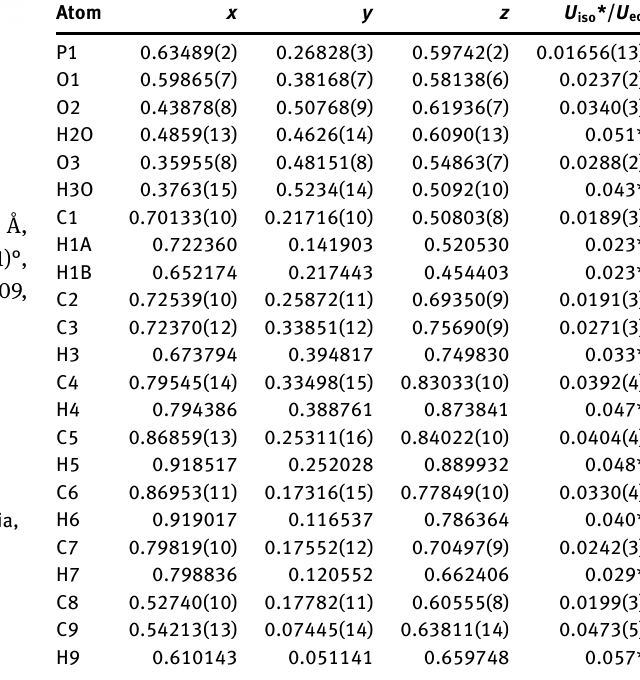
Table 2: Fractional atomic coordinates and isotropic or equivalent isotropic displacement parameters (Å 2